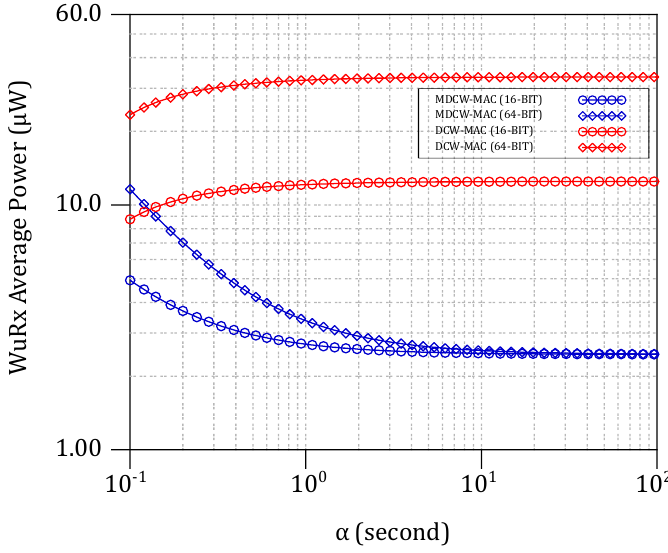
Figure 16. Average WuRx power consumption of the DCW-MAC and MDCW-MAC when decoding 16-bit and 64-bit